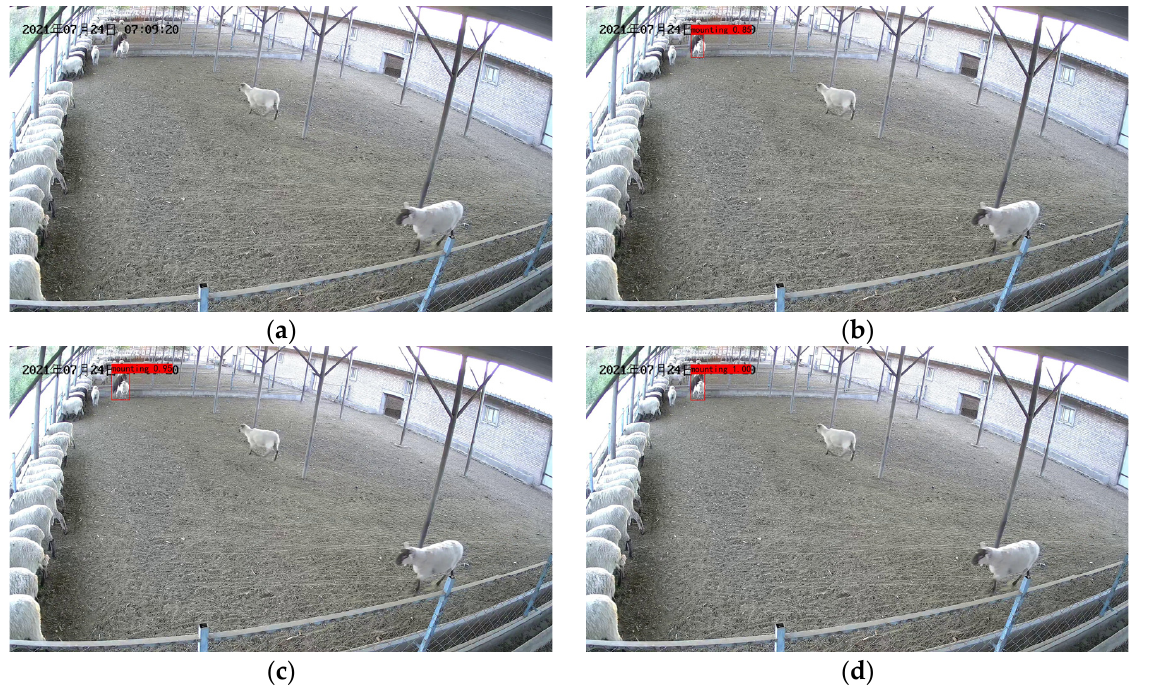
Figure 14. Recognition results in the presence of long distances: ( a ) Original image; ( b ) YOLOv3 recognition results; ( c ) YOLO v4 recognition results; ( d ) Identification results of our model. The Chinese characters in the upper left corner of the image are the date of the video recording, in order of year, month, and day.